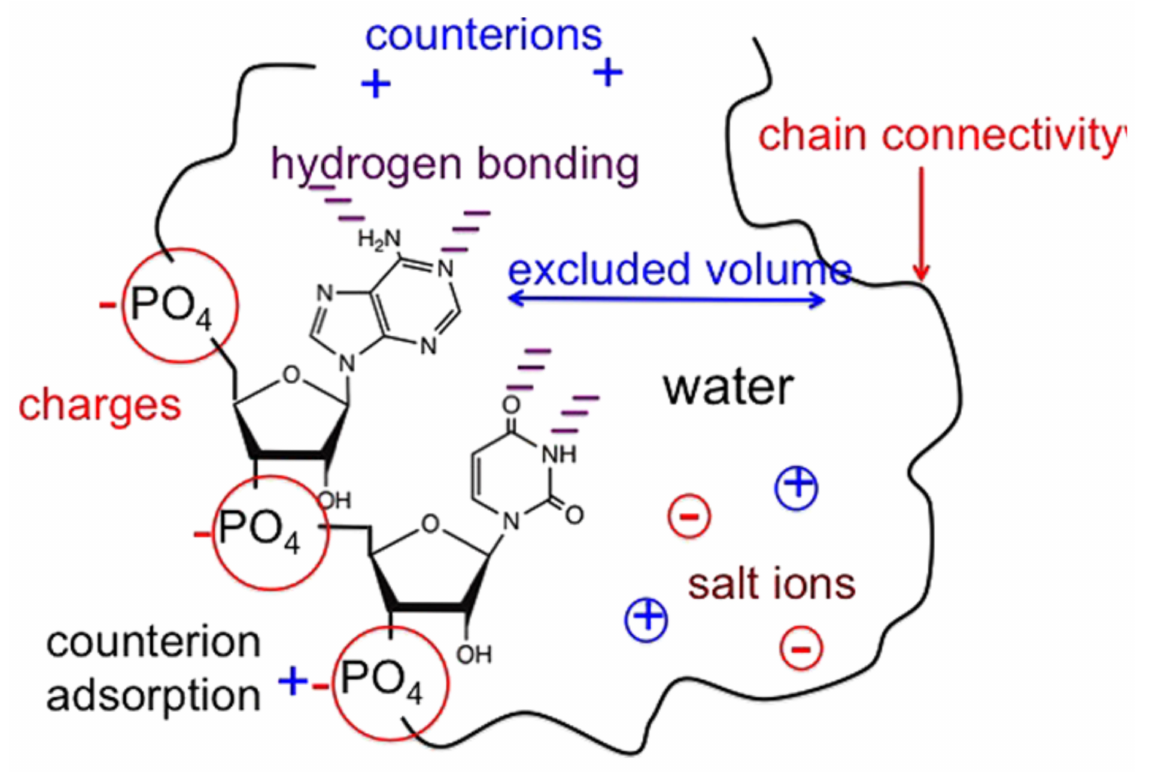
Figure 1. Charged polymer and chain connectivity